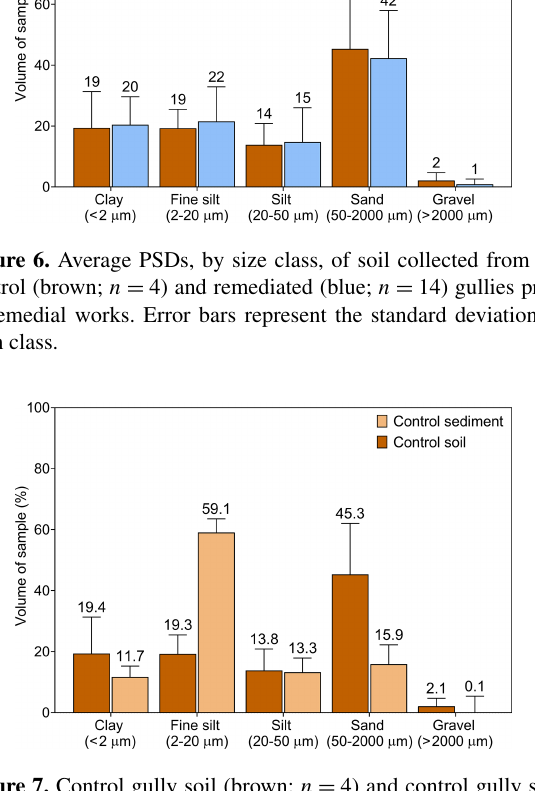
Figure 7. Control gully soil (brown; n = 4) and control gully sus- pended sediment (light brown; n = 6) PSD by size class. Error bars represent the error as a standard deviation for the soil and sediment PSDs, respectively.